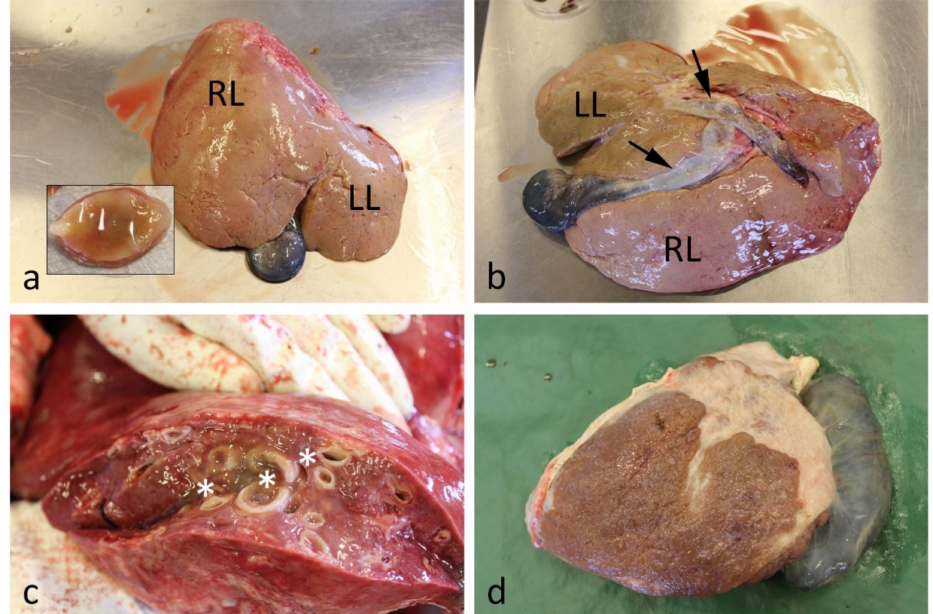
Figure 1. Gross pathology of chronic fasciolosis. ( a ). The diaphragmatic surface of the liver is irregular with elongated shallow depressions on both the left lobe (LL) and right lobe (RL). The inset image shows a mature Fasciola hepatica . ( b ). On the visceral side, the cystic bile duct that empties into the gall bladder and the duct in the hilar area (arrows) is markedly dilated. The same rough surface as in image ( a ) is evident. ( c ). The cut surface shows many dilated bile ducts with thickened walls (asterisks). The liver parenchyma is marbled because of fibrosis. ( d ). A severely fibrotic, small, and deformed liver with a dilated gall